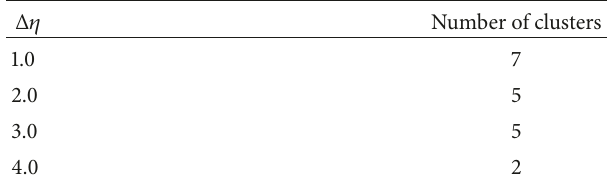
Table 3: Trend of number of clusters is selected from each of the four 𝜙 -data sets [corresponding to the pseudorapidity regions around 𝑐 𝑟 for 32 S-AgBr ( 200 A GeV) interaction] which have almost similaraverageclusteringcoefficienttotheirMonte-Carlosimulated